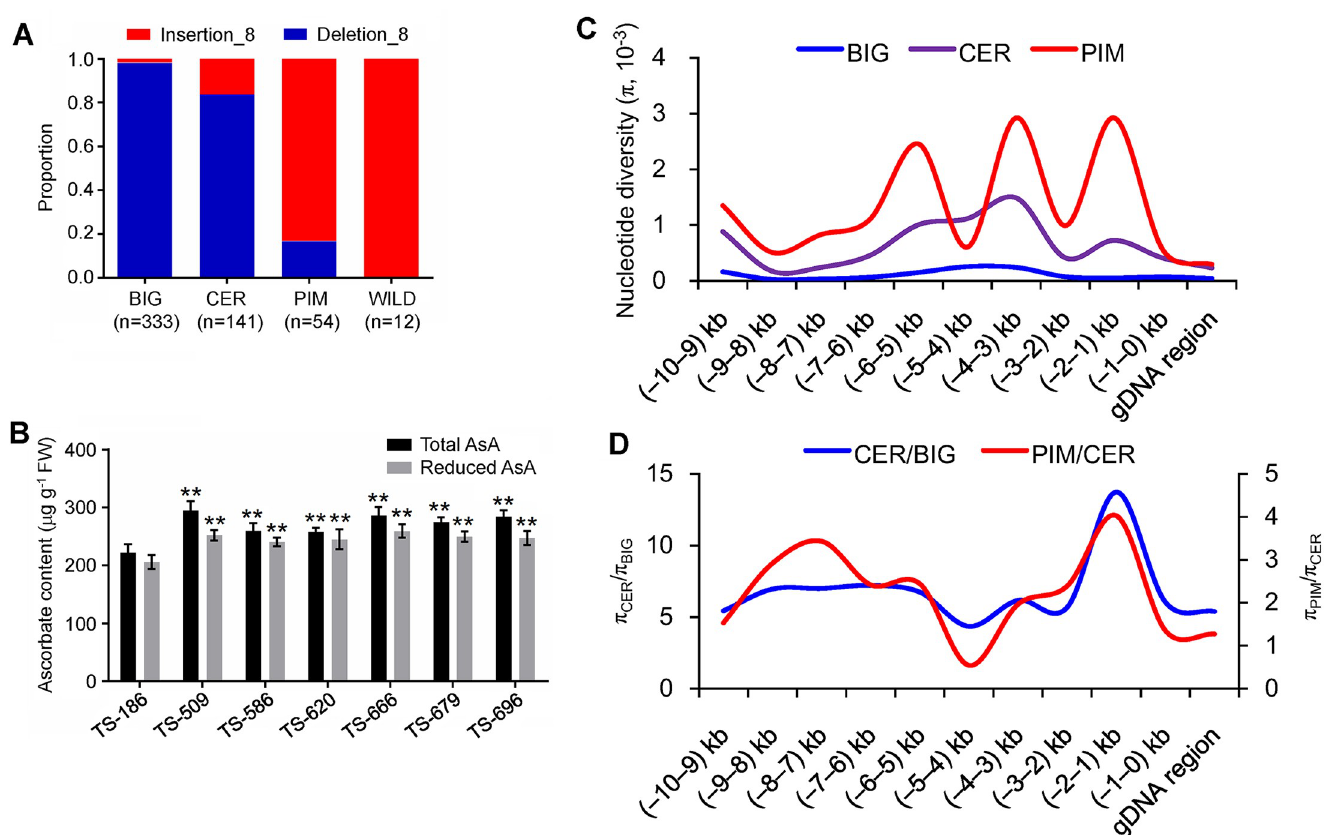
Fig 6. Nucleotide diversity analysis of TFA9 loci during tomato domestication and improvement. (A) Frequency of derived and ancestral InDel_8 allele in tomato subpopulations. n = number of accessions. (B) Comparison of ascorbate content of Hap 1 accession TS-186 and six Hap 4 accessions in BIG subgroup. The data are presented as means ± SE (n = 3). The asterisks represented significant differences from TS-186 (Hap 1), as indicated by the t -test ( �� P < 0.01). (C) Distribution of nucleotide diversity ( π ) of the PIM (red line), CER (purple line), and BIG (blue line) within the 10-kb region of TFA9 . Grey lines indicate the locations of indel_8 (TCTCTTTC/-). The X-axis denotes the position of SlbHLH59 and the Y-axis indicates average p values. (D) The ratio of nucleotide diversity ( π ) is calculated from the SlbHLH59 sequence of PIM with CER (red line) and CER with BIG (blue line). In total, 331 tomato accessions were used for analysis, including 53 PIM accessions, 112 CER accessions, and 166 BIG accessions.